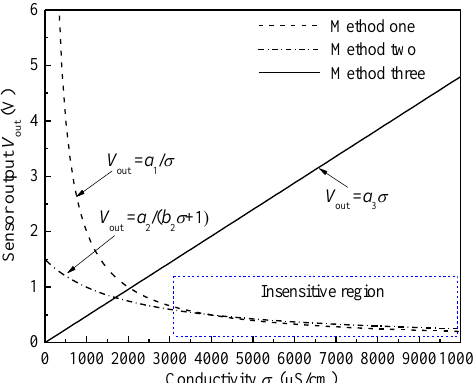
Figure 2. The relationships between the conductivity and the sensor output of three typical conductivity detection methods.